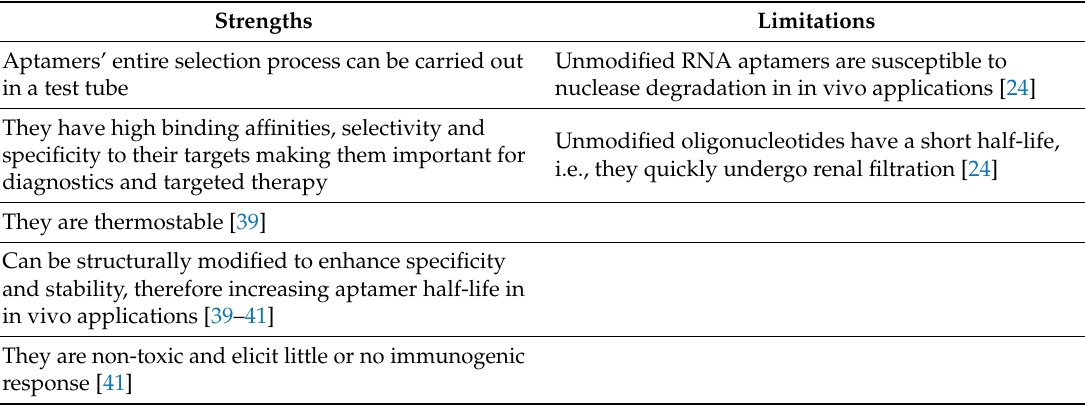
Table 1. Strengths and limitations of aptamer